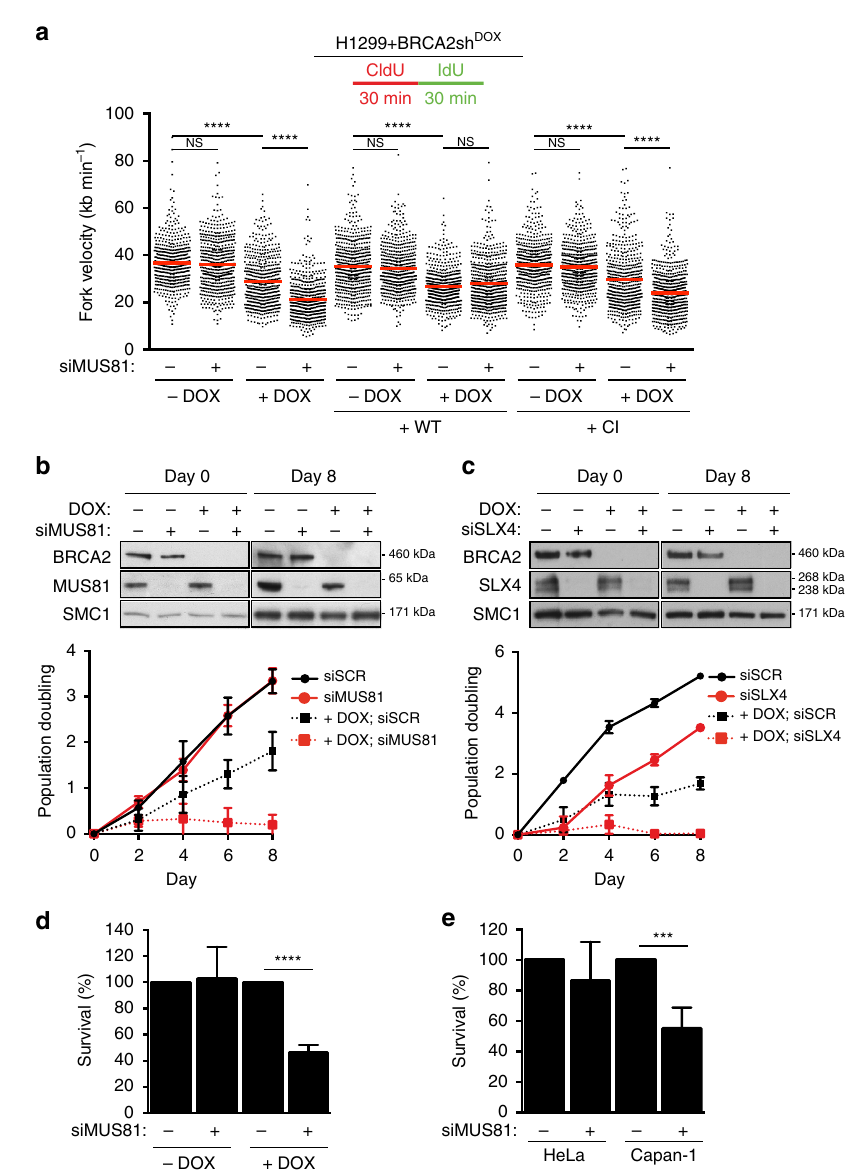
Figure 1 | MUS81 facilitates replication and sustains proliferation in cells lacking BRCA2. ( a ) H1299 cells carrying a doxycycline (DOX)-inducible BRCA2 shRNA were transfected with control or MUS81 siRNAs. Stable cells lines expressing either wild type (WT) or catalytically inactive (CI) human MUS81 were similarly processed. Cells were processed 24h later for DNA fibre analysis as outlined in the inset, followed by quantification of CldU þ IdU track length. Fork velocity was calculated using a conversion factor of 1 m m ¼ 2.59kbmin (cid:2) 1 . Red bars indicate mean ( n ¼ 3). **** P o 0.0001 (two-tailed